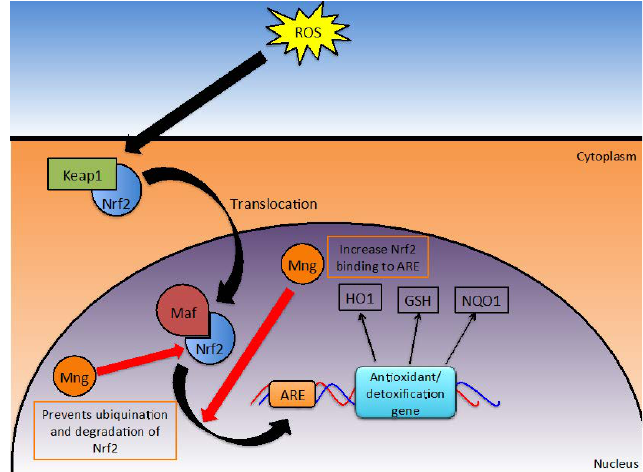
Figure 5. Effect of Mangiferin on the Nrf2/ARE Detoxification Pathway.